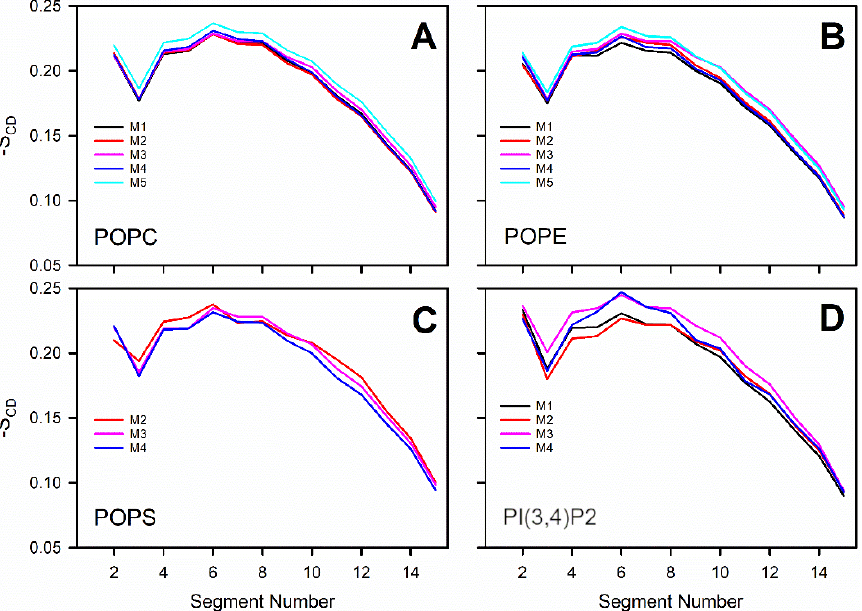
Figure 2. Molecular order parameter -S CD : comparison of the models for each lipid species: ( A ) POPC, ( B ) POPE, ( C ) POPS, and ( D ) PI(3,4)P2 (Figure 1). The membrane models (Models #1–#5 or M1–M5; Table 1) are shown with distinct colored lines.